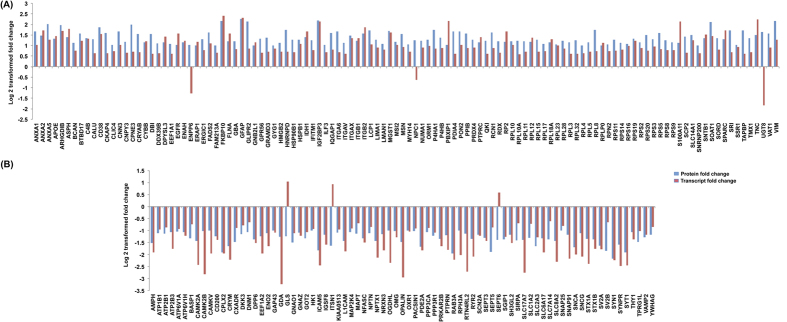
Comparison of differentially expressed proteins observed DA with differential expression reported at transcript levels.The total number of differentially expressed proteins observed in the present study was compared with differentially expressed transcript data available in Oncomine resource (www.oncomine.org, ref. 11). (A) shows profiles of upregulated entities and (B) represents downregulated entities. The fold change values of these entities are given in Supplementary Table S2.